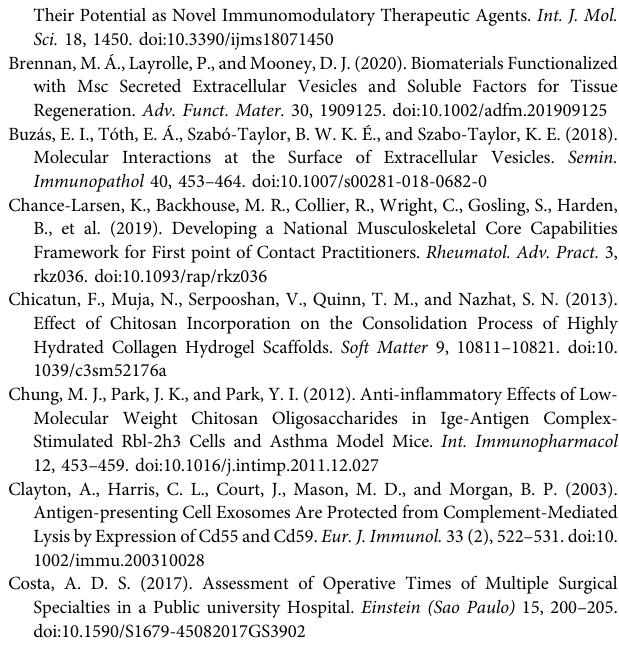
Supplementary Figure 1 | Morphology of pre-osteoblast within chitosan-collagen hydrogels following 3 days in basal culture. Scale bar = 200 µm. Supplementary Figure 2 | Pearson correlation of EV cumulative release kinetics within composite hydrogel. Supplementary Figure 3 | The size distribution of EVs before and after incorporation into hydrogel systems analysed via DLS analysis. Supplementary Figure 4 | The effect of hydrogel-released EVs on hBMSCs migration rate at day 3. White dash lines indicate initial baseline scratch. Scale bar = 100